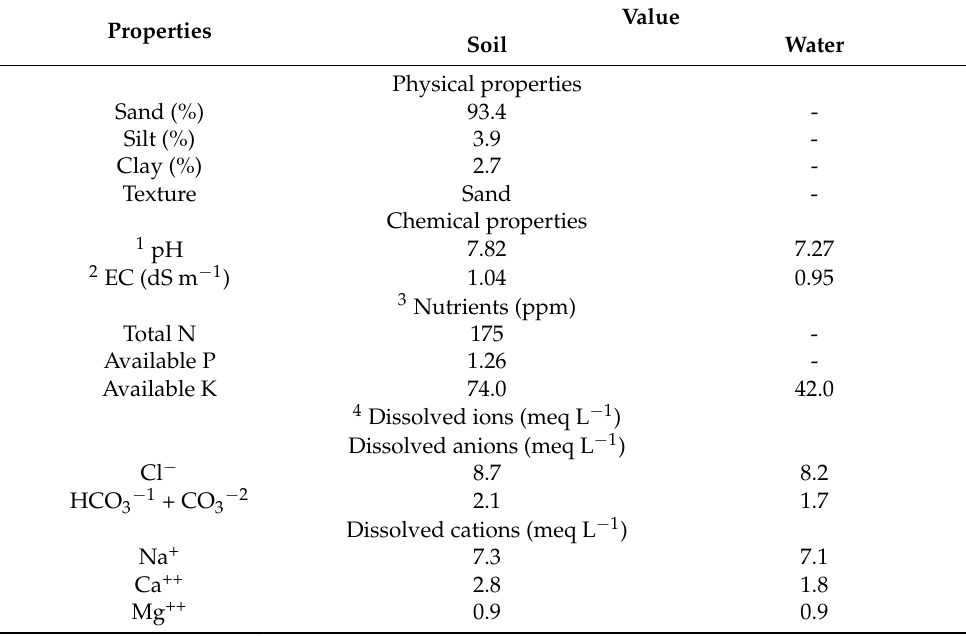
Table 4. Physical and chemical properties of soil and water used for the